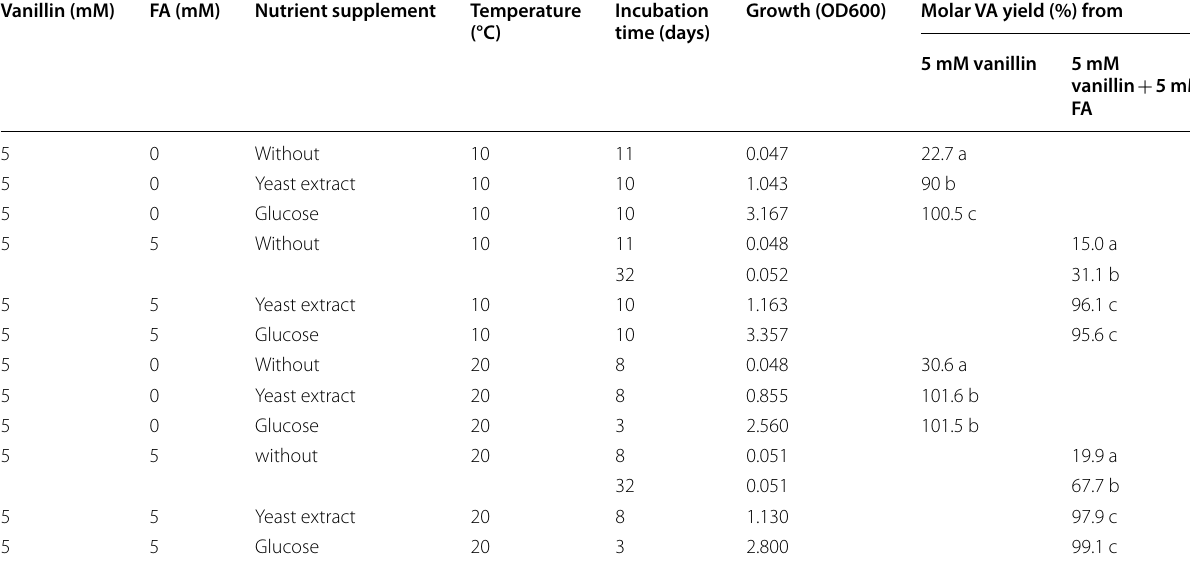
Different letters (a-c) indicate statistically significant differences (LSD, p